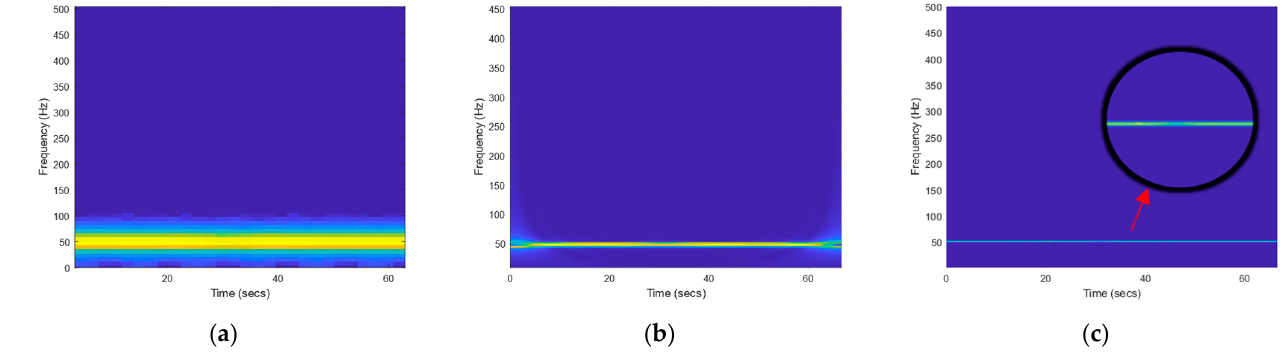
Figure 3. The simulation data using STFT, CWT, and SSWT processing time-frequency diagram; ( a – c ) are STFT, CWT, and SSWT images.